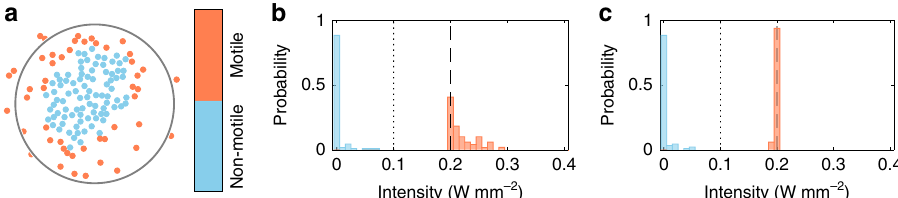
Fig. 7 Adjustment of the illumination intensity. a Particle con fi guration taken from Fig. 1a – c with assigned particle activity. Motile particles are supposed to be illuminated with intensity I = 0.2 W mm − 2 (dashed line in b , c ) and non-motile ones with intensity I < 0.1 W mm − 2 (onset of propulsion, dotted line in b , c ). b Without corrections of the illumination intensity, the majority of motile particles (red) is illuminated too strong. c Using the intensity adjustment according to Eq. (5), all motile particles are illuminated with the allocated